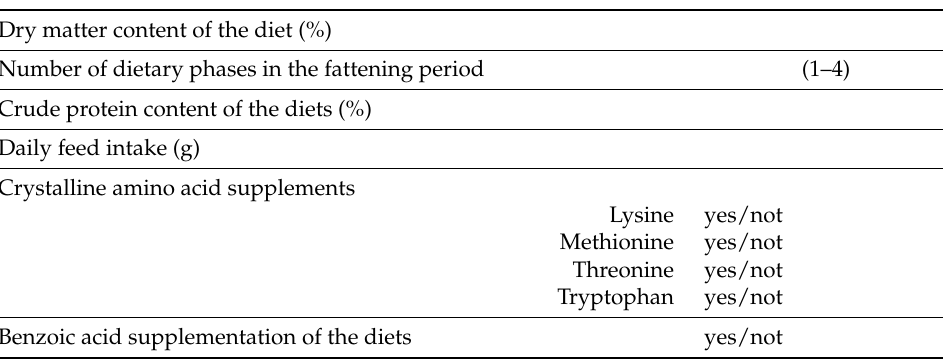
Table 2. Input data of the nutrition